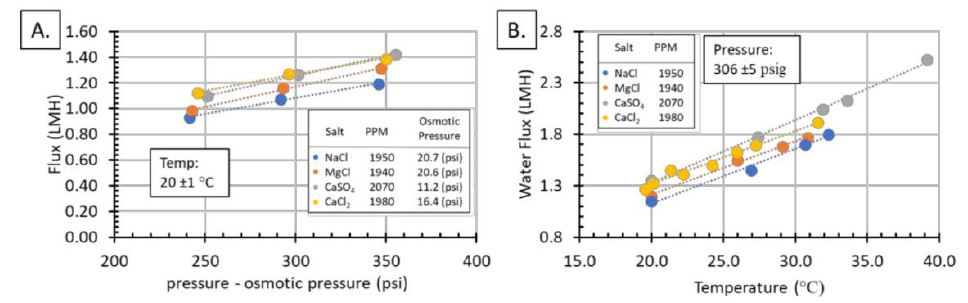
Figure 5. Water flux increased linearly with pressure ( A ) and temperature ( B ). This is expected behavior for RO membranes. The order of water flux by salt solution was CaSO 4 > CaCl 2 > MgCl 2 > NaCl.